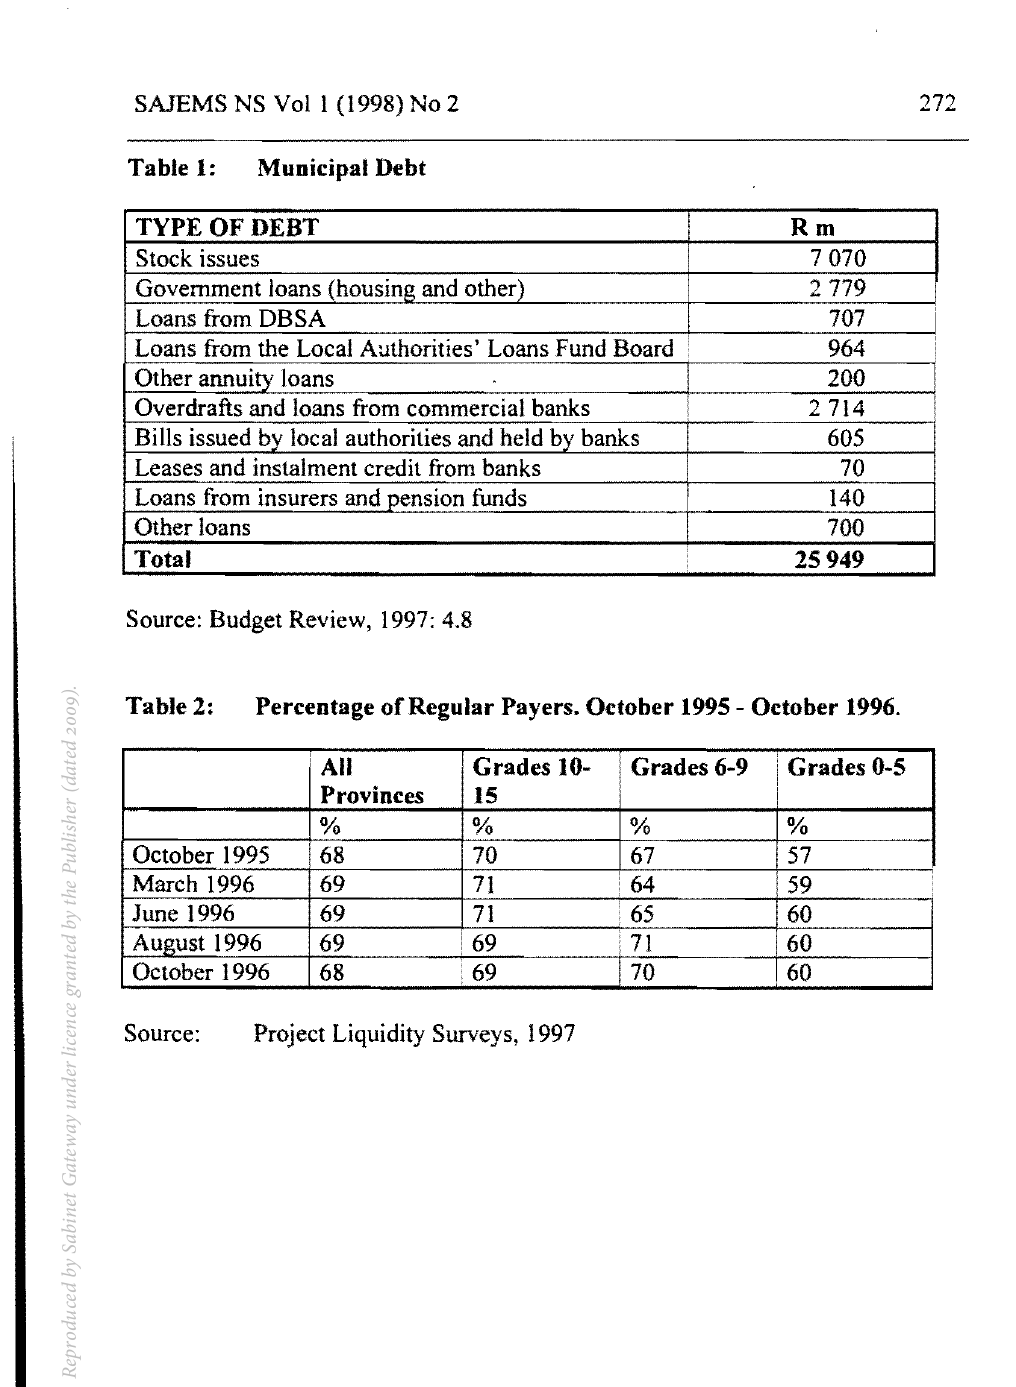
Percentage of Regular Payers. October 1995 - October